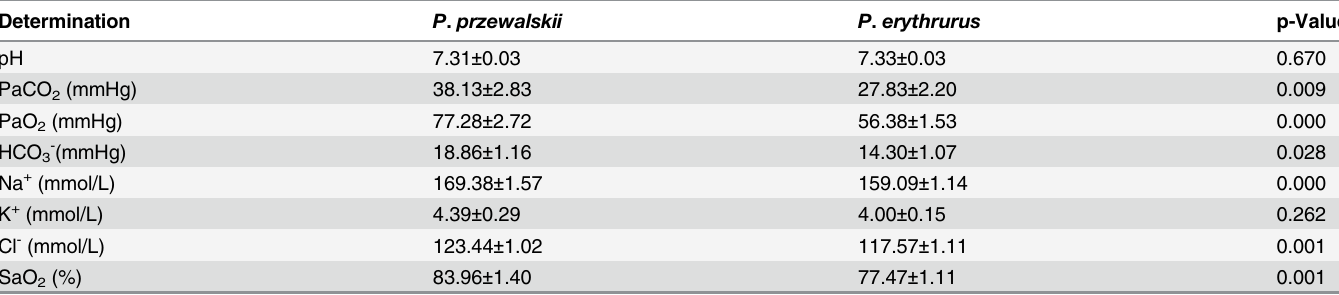
Table 4. Arterial blood gas measurements of P . erythrurus and P . przewalskii .